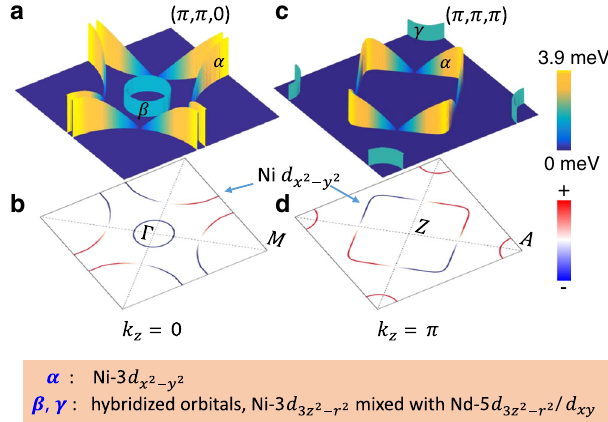
Fig. 5 Cartoon picture for the Fermi surfaces and the gap structure. a, b The Fermi surfaces and the gap amplitude at cut k z = 0. A d -wave gap is formed on the α Fermi pocket centered around Γ , and a full gap may appear on the β pocket. Actually the Fermi surface on the α pocket at this cut looks very similar to that of underdoped cuprates. The height of the colored walls in a represents gap magnitude on each Fermi surface . c, d The Fermi surfaces and the gap amplitude at the cut k z = π . A d -wave gap is formed on the α Fermi pocket centered around Z, now the Fermi surface becomes a closed square like mimicking that of overdoped cuprates, and a full gap may appear on the γ pocket around A. The height of the colored walls in c indicates the gap magnitude on each Fermi surface. The blue and red colors in b and d represent the gap signs. Note, about the full gaps on the β and γ pockets, we depict them with different colors. As mentioned in the main text, it remains unknown whether the gaps on the β and γ pockets are really fully gapped, and whether they have opposite